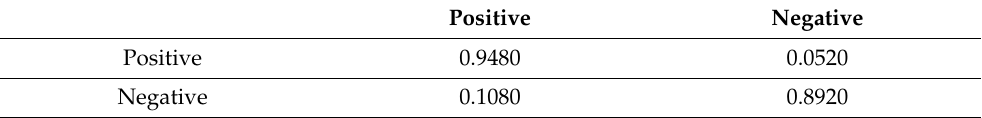
Table 19. Confusion matrix of the proposed ensemble model for D3, i.e., the Coswara speech dataset.